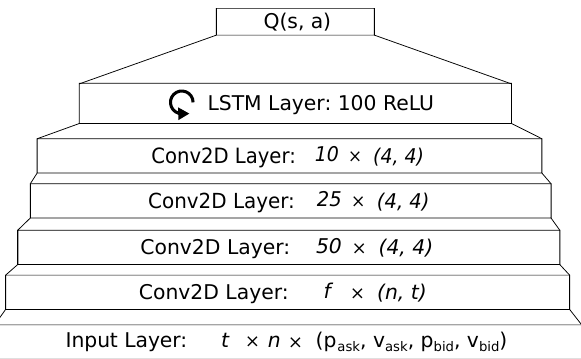
Figure 4. The neural network architecture used in our evaluation. For a number of observed assets n over a time span t , the input layer consists of ( t × n × 4 ) input neurons. For the following convolutional layer, we choose the number of filters f , such that the resulting activation shape fits into the later convolutional layers. After the convolutional part, we employ a LSTM layer, consisting of 100 recurrent neurons with rectified linear activation.